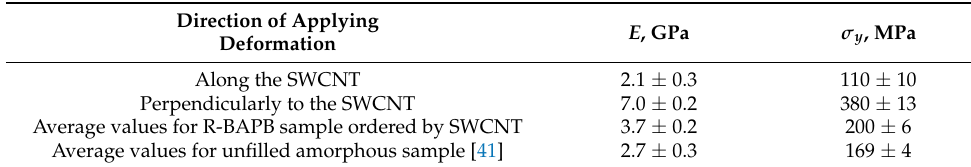
Table 2. Mechanical properties (values of Young’s modulus E and yield stress σ y values) ordered by SWCNT R-BAPB samples, calculated along and perpendicularly to the SWCNT axis. The results for unfilled amorphous R-BAPB samples were taken from the previous study [41] for comparison. The results were obtained by computer simulations using Equation